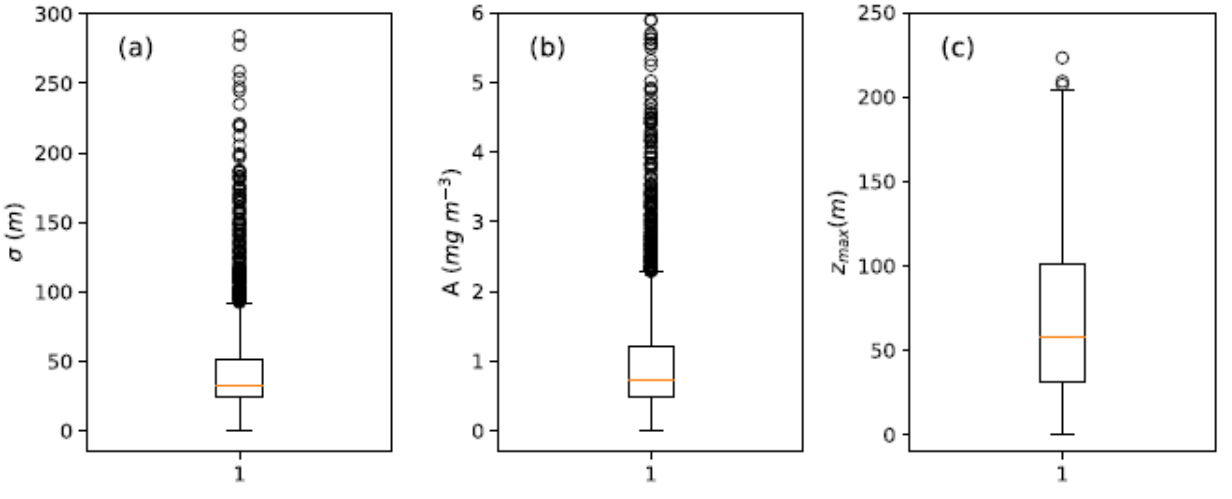
Figure 3. Boxplot of three parameters (standard deviation ( a ); amplitude of the Gaussian curve ( b ); location of the amplitude ( c )) in the Gaussian function in the northwestern Pacific Ocean. In each box, the orange horizontal line represents the median. The upper and lower horizontal lines of the box represent the 75th and 25th percentiles (Q3 and Q1), respectively. The upper and lower horizontal whiskers lines are the upper limit (U) and lower limit (L) of the data, respectively; the circles represent the outliers.